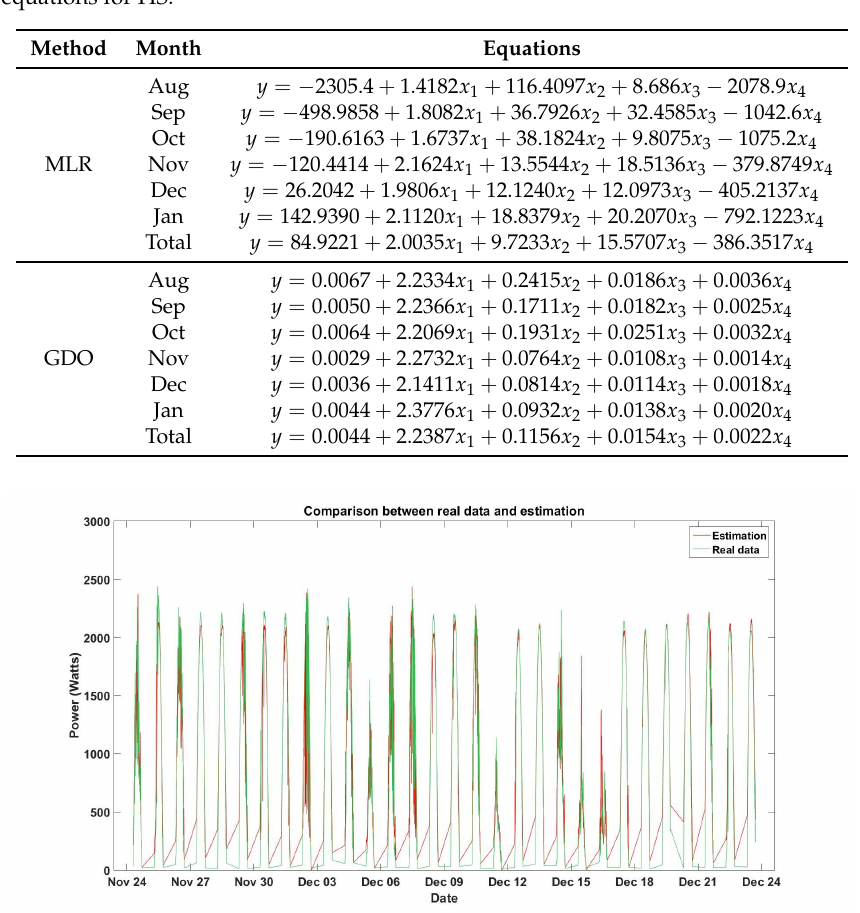
Figure 7. MLR results from